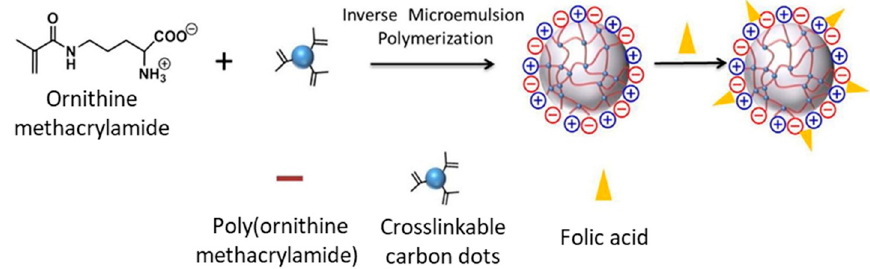
Figure 15. Monomer structure and zwitterionic nanogel-carbon dots assembly. Reprinted from Reference [85], Copyright (2016), with permission from Elsevier.